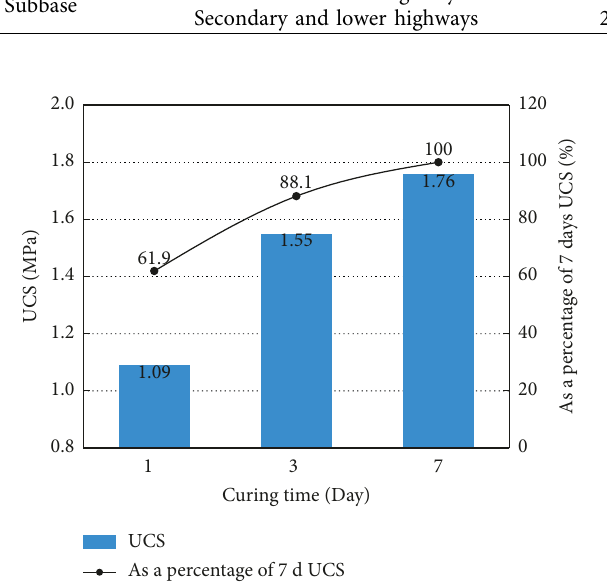
Figure 8: UCS of MOC solidified soil with different curing time.